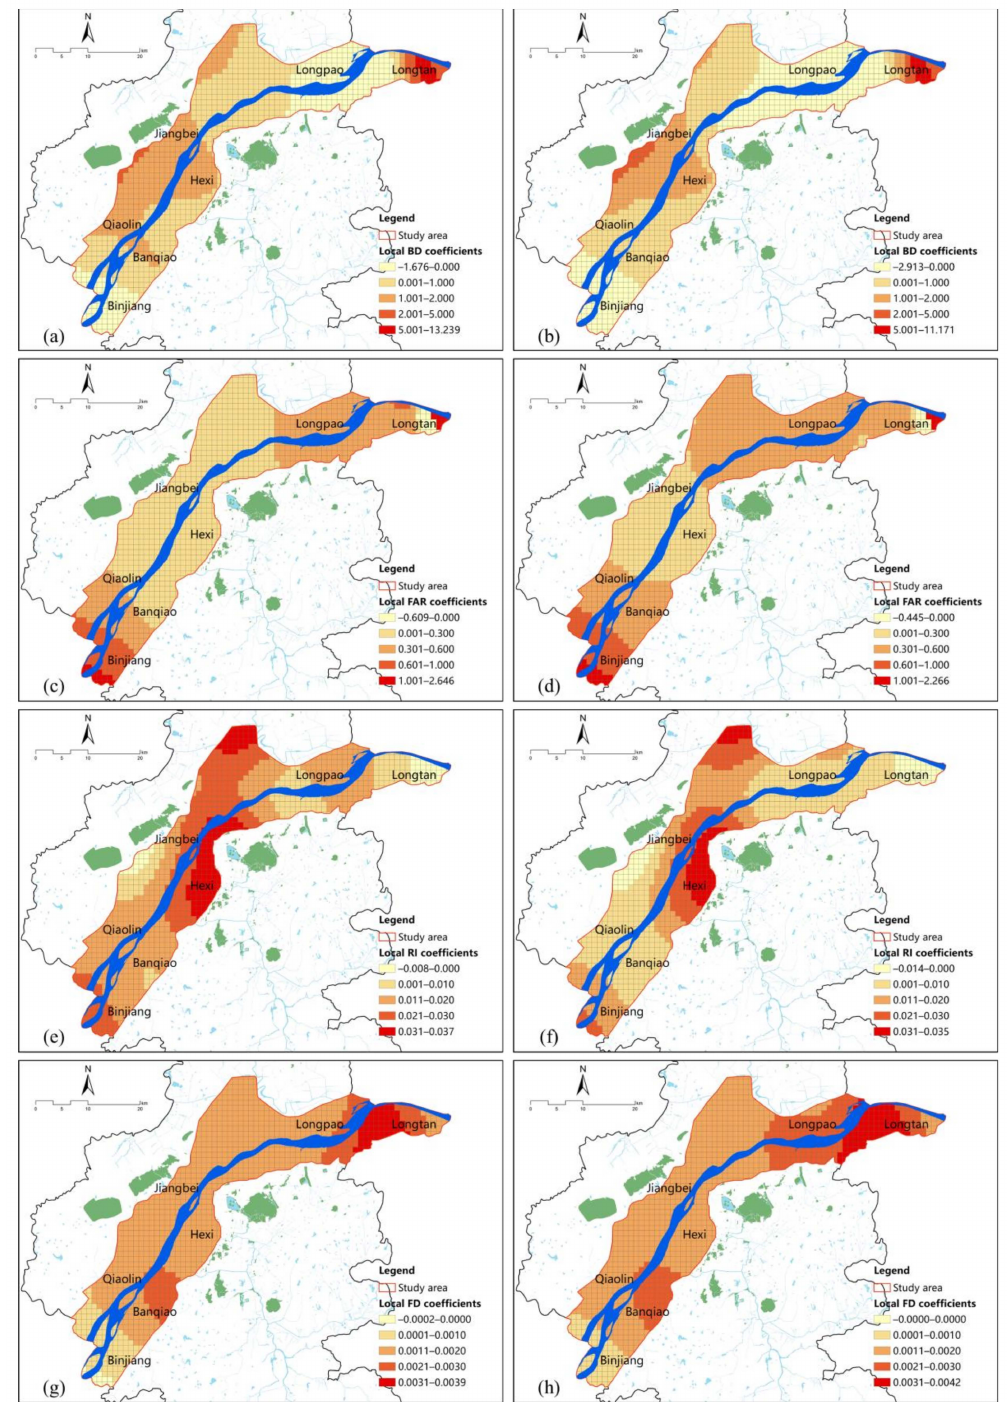
Figure 5. Spatial characteristics of estimated coefficients of built environment variables with GWR: ( a ) local BD coefficients on weekdays; ( b ) local BD coefficients on weekends; ( c ) local FAR coefficients on weekdays; ( d ) local FAR coefficients on weekends; ( e ) local RI coefficients on weekdays; ( f ) local RI coefficients on weekends; ( g ) local FD coefficients on weekdays; ( h ) local FD coefficients on